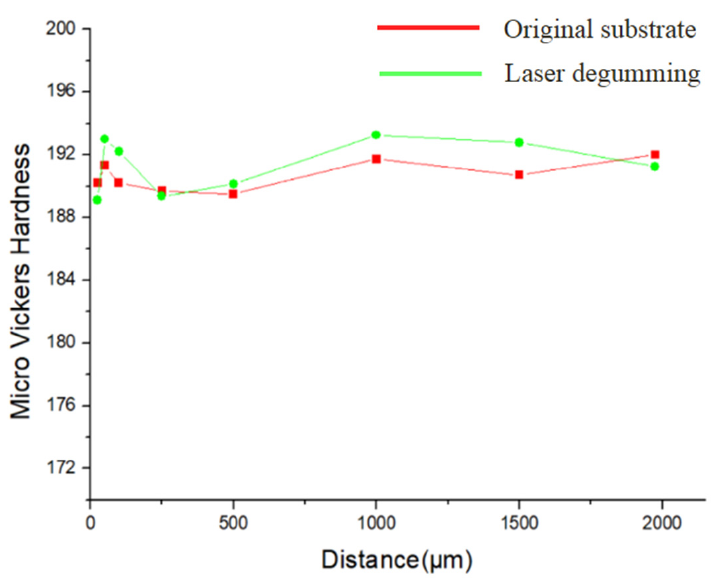
Figure 8. Micro-Vickers hardness as a function of the distance from the top surface.